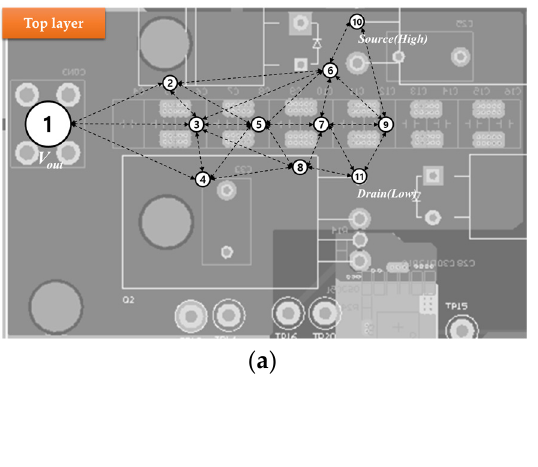
Figure 14. The simplified essential points from Figure 8b,c. ( a ) Top layer. ( b ) Bottom layer of high side. (c) Bottom layer of low side.